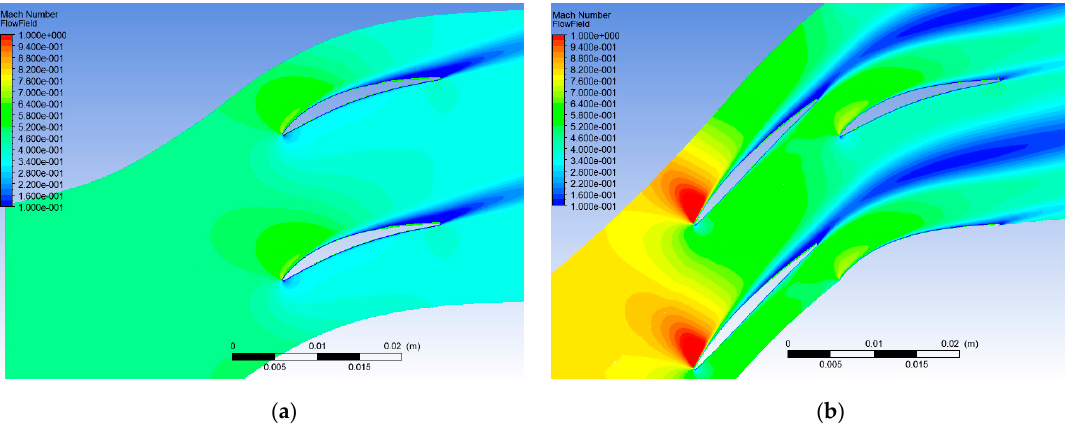
Figure 13. Comparison of Mach contours in single-blade and tandem configurations. FB incidence +5°; FB inflow Mach number 0.8. ( a ) AB single-blade configuration; ( b ) tandem configuration.